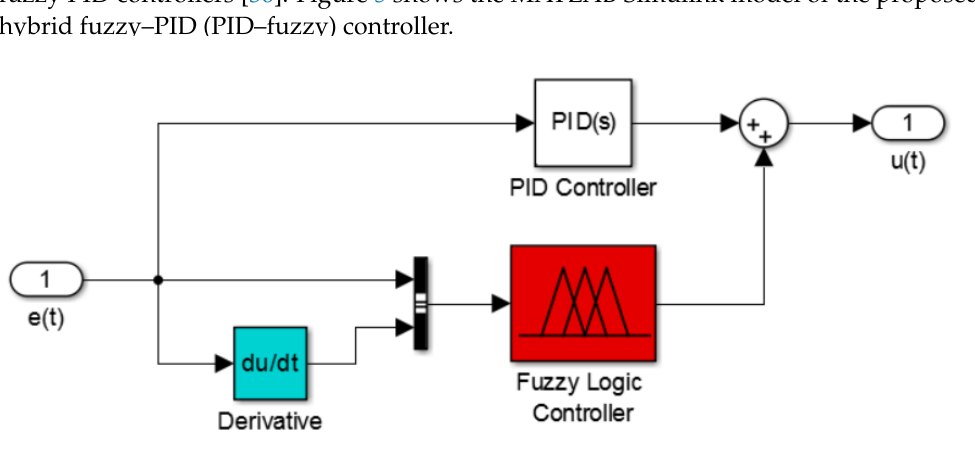
Figure 5. Proposed hybrid PID–fuzzy-based controller.